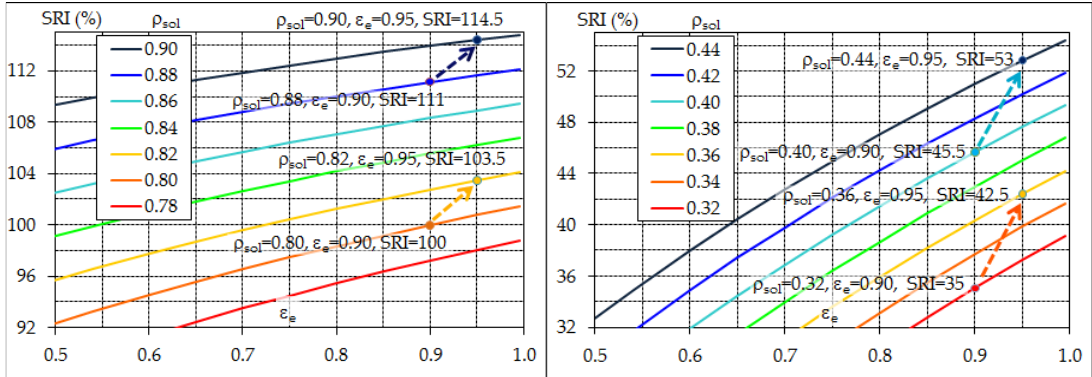
Figure 14. Theoretical discrepancies of calculated SRI values for intermediate wind speed (2 m/s < v wind < 6 m/s, h ce = 12 W/(m 2 K)) and (from left to right) highly reflective and moderately reflective surfaces.